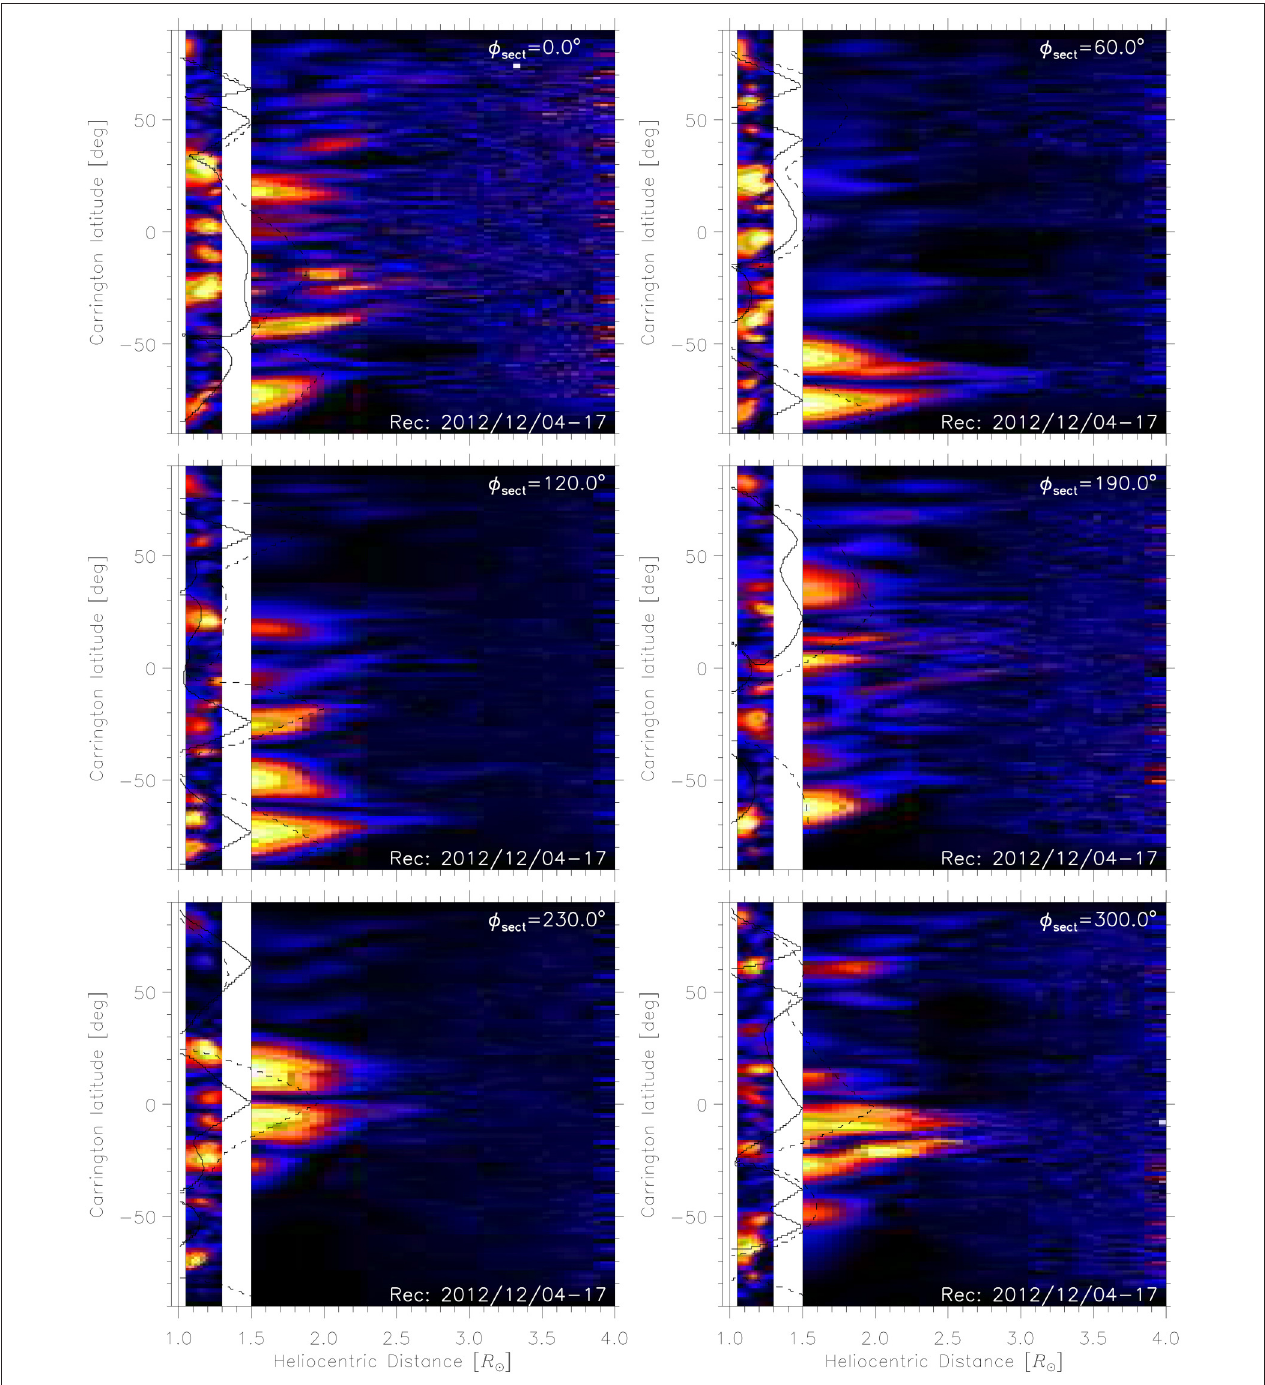
FIGURE 4 | Longitudinal cross-sections of gradient of electron density and EUVI 195 emissivity, ∂ N e /∂θ and ∂ε 195 /∂θ , for CR 2131. Carrington longitudes for cross-sections are shown at upper right corners. Color scales are different for different cross-sections to enhance the images. The contour black lines show boundaries between open and closed magnetic-field structures for the PFSS models with Source Surface located at 1.5 and 2.0 R ⊙ .